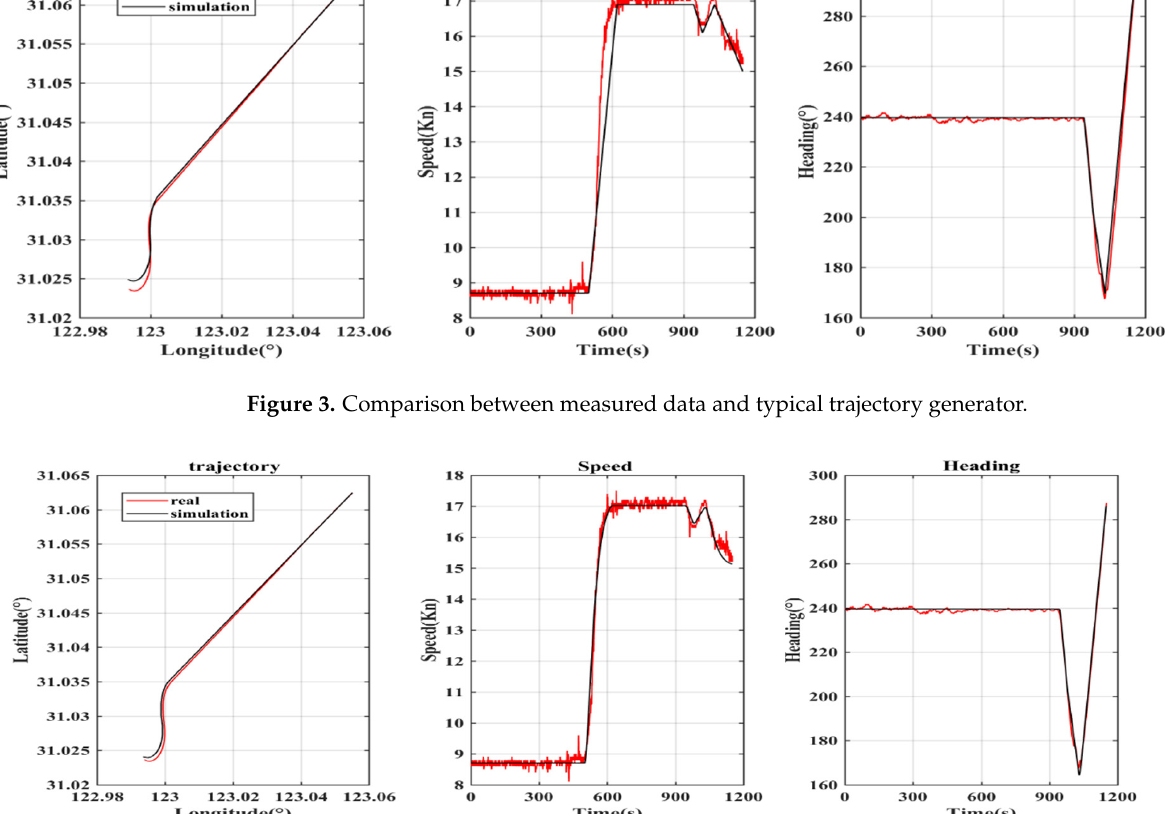
Table 3. Accuracy and RMSE comparison results.